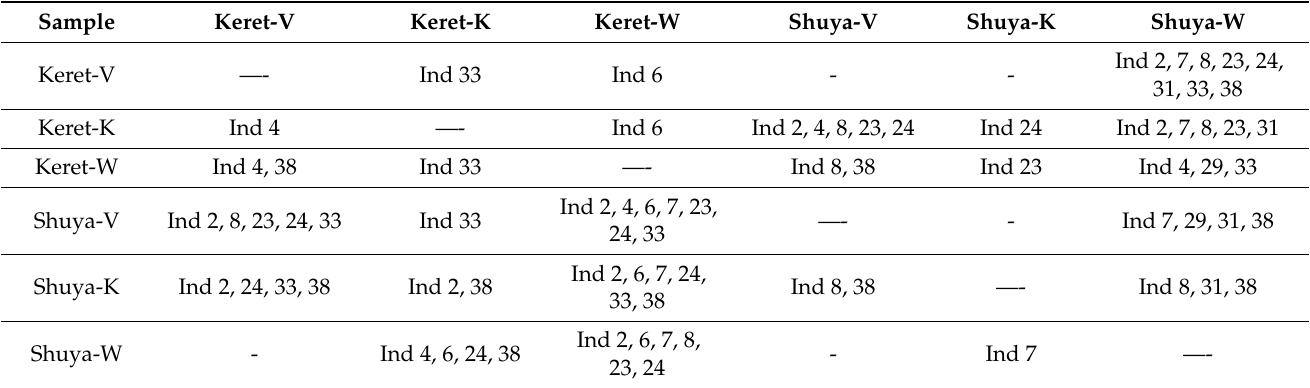
Table 4. Significant differences between juvenile Atlantic salmon samples with respect to the cranial bone indices that do not correlate with the body length (results of one-way ANOVA, p < 0.01 above the diagonal, p < 0.05 below the diagonal). The indices are designated as in Table 2.